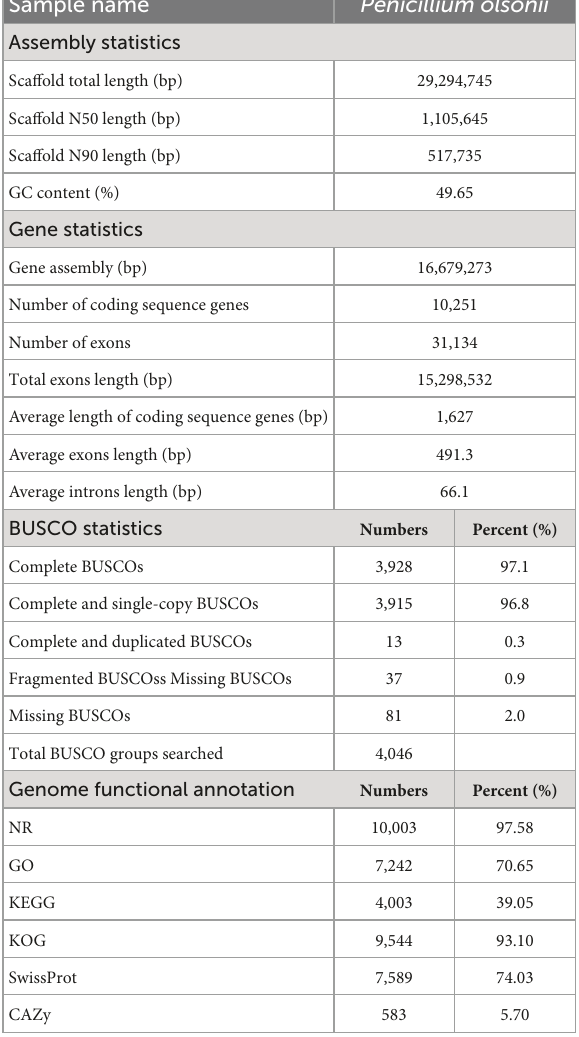
TABLE 1 Genome assembly and annotation statistics of Penicillium olsonii